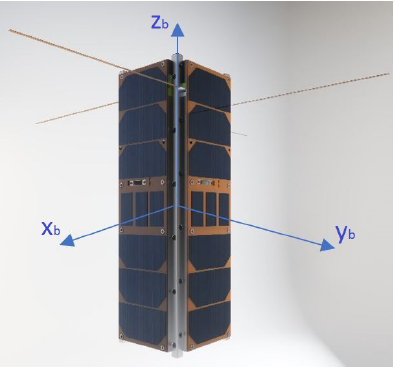
Figure 2. Representation of ABCS and its body-fixed reference